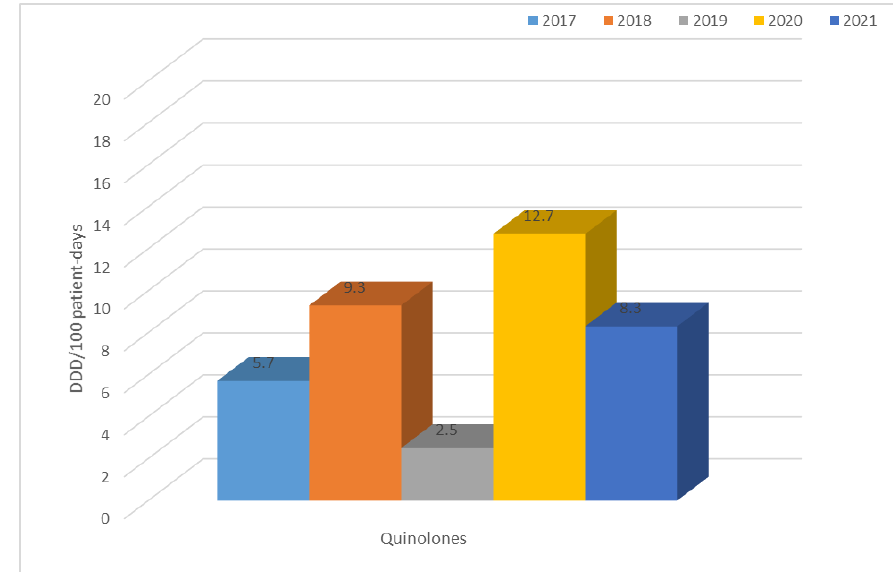
Figure 24. Consumption of quinolones (ciprofloxacin and levofloxacin) in 2017–2021. The situation is similar for third-generation cephalosporins (Figure 25), the use of which increased sharply in 2020 (reaching as much as 15.7/100 patient days), but in 2021, the level of their consumption was 7.4 DDD/100 patient days, which is still almost three times higher than in 2017–2019.